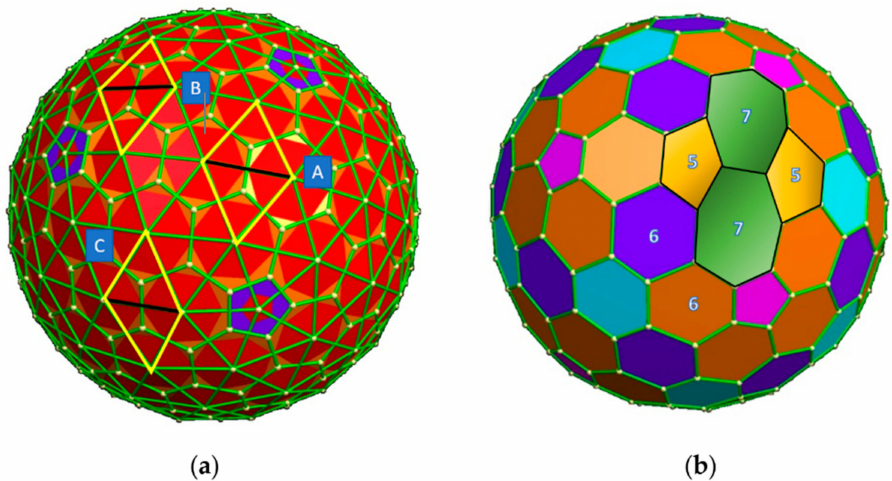
Figure 3. ( a ) Pristine C 240 ( I h ) fullerene has three symmetry-independent quartets of hexagons A, B, and C delimited by yellow diamonds whose corners correspond to the centers of the hexagons. ( b ) The η = 0 C structure generated by applying the SW 6 | 6 rotation to quartet A in ( a ). The double pair 5 | 7 and 240 SWw with length η = 0 are shown. Yellow (green) polygons represent pentagonal (heptagonal) rings. The pair 6 | 6 is ready for the SW 6 | 7 rotation and swap place with the nearby pair 5 |